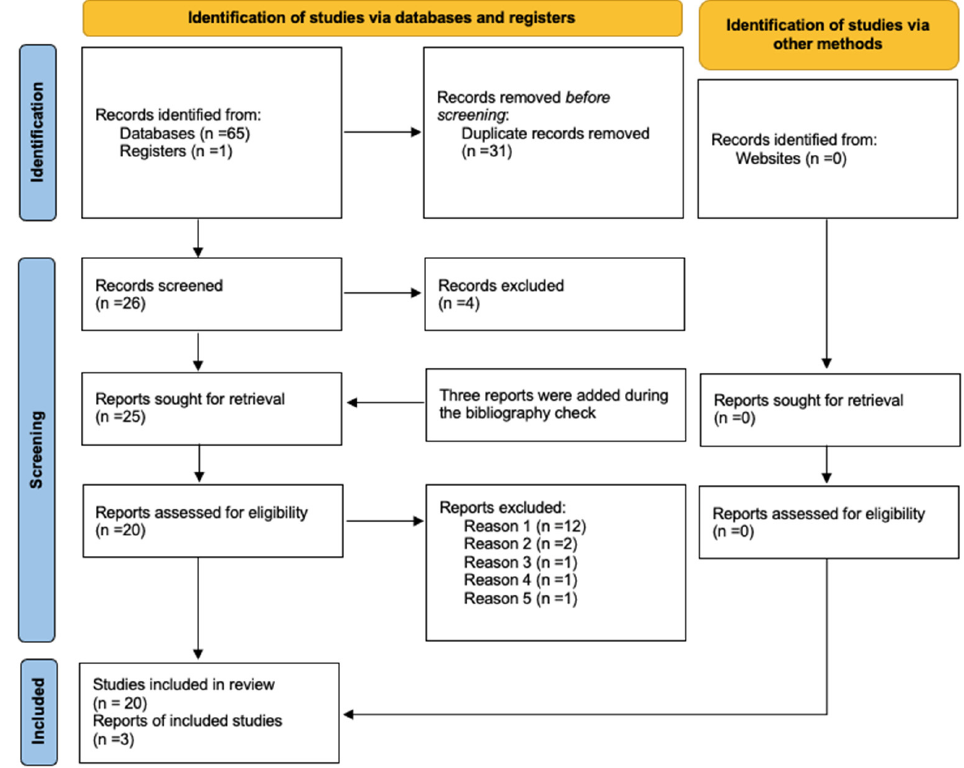
Figure 1. PRISMA flow-diagram. The reasons for exclusion: reason 1: papers which did not consider ICU population; reason 2: papers which evaluated different outcome (i.e., renal replacement therapy, superinfections); reason 3: analyzed MR-proADM levels among children versus adult patients; reason 4: considered pro-ADM levels with a different technique (bioactive ADM); reason 5: presented a population already included in a previously published study.